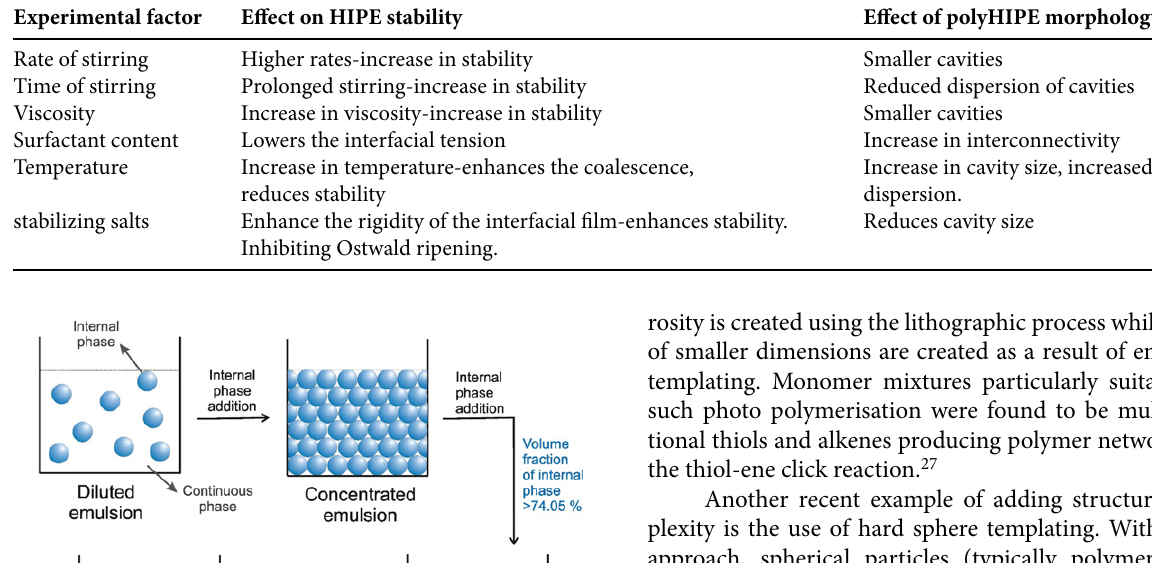
Table 1: Experimental factors and their effect on HIPE stability and polyHIPE morphology Experimental